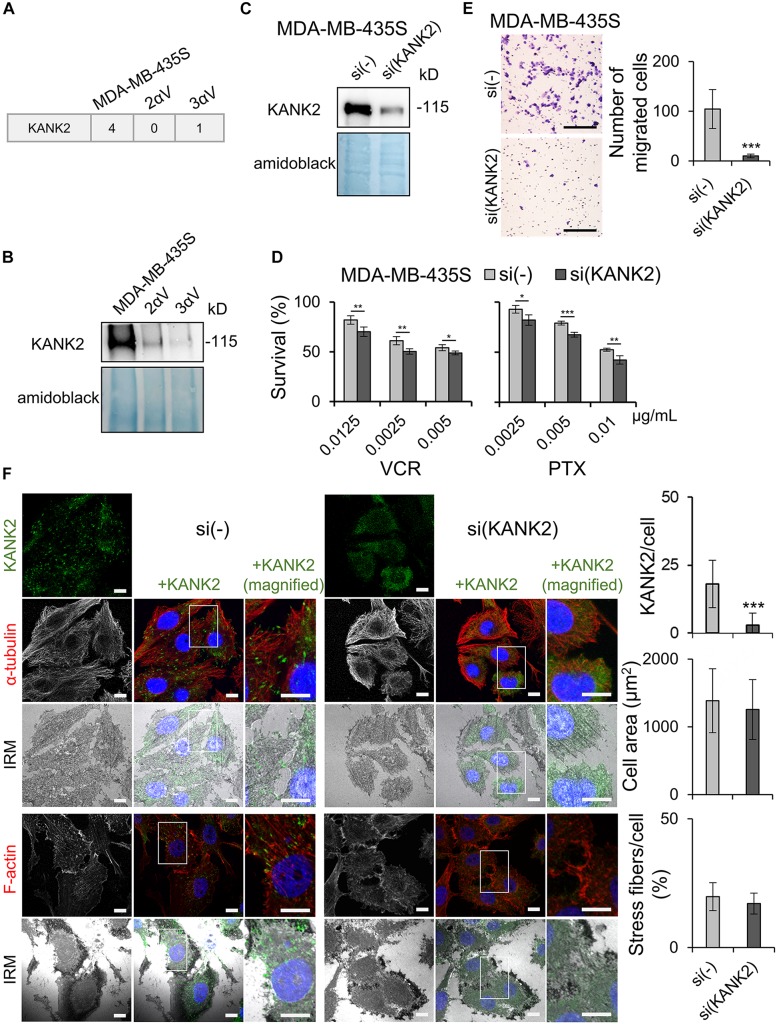
KANK2 knockdown in MDA-MB-435S cells increases sensitivity to MT poisons and decreases migration mimicking integrin αV knockdown. (A) Average MS data of number of spectra specific for KANK2 in MDA-MB-435S cell model. Dataset consists of at least two different experiments. (B) KANK2 is present in lower amount in IACs of clones 2αV and 3αV. WB analysis of KANK2 in isolated IAC proteins from clones 2αV and 3αV and MDA-MB-435S cells. Forty-eight hours after seeding, IACs were isolated and WB analysis was performed. The results presented are representative of two independent experiments yielding similar results. (C) Knockdown of KANK2 in MDA-MB-435S cells. WB analysis of KANK2 from MDA-MB-435S cells transfected with either control (si(-)) or KANK2-specific siRNA (si(KANK2)). Forty-eight hours after transfection total cell lysates were collected and WB analysis was performed. The results presented are representative of two independent experiments yielding similar results. (D) MDA-MB-435S cells upon KANK2 knockdown demonstrate increased sensitivity to VCR and PTX as compared to MDA-MB-435S cells transfected with control siRNA. Twenty-four hours upon transfection, cells were seeded in 96-well plates and 24 h later treated with different concentrations of VCR and PTX. Cytotoxicity was measured by MTT assay. Results presented are representative of three independent experiments with similar results ± SD. Data were analyzed by unpaired Student’s t-test. *P < 0.05; **P < 0.01; ***P < 0.001. (E) KANK2 knockdown decreases migration in MDA-MB-435S cells. Serum starved (24 h) cells, transfected previously with either control or KANK2-specific siRNA were seeded in Transwell cell culture inserts and left to migrate for 22 h toward serum. Cells on the underside of the inserts were stained with crystal violet, photographed, and counted. Scale bar = 100 μm. Averages of five microscope fields of three independently performed experiments ± SD are shown (n = 3). Data were analyzed by one-way ANOVA with Dunnett’s multiple Comparison. ***P < 0.001. (F) KANK2 knockdown in MDA-MB-435S cells does not alter cell size or amount of stress fibers but slightly alters appearance of MTs. Forty-eight hours after transfection of MDA-MB-435S cells with KANK2-specific or control siRNA cells were fixed, permeabilized, and stained with anti-KANK2 antibody, followed by Alexa-Fluor 488-conjugated antibody (green). The α-tubulin or F-actin staining (red) was performed, nuclei were stained with DAPI (blue) and IRM images were taken. Analysis was performed using TCS SP8 Leica. Scale bar = 10 μm. Quantification data of results are presented as histograms represent measurements of > 50 cells and are plotted as mean ± SD (n = 2). Data were analyzed by one-way ANOVA with Dunnett’s multiple comparison. ***P < 0.001.